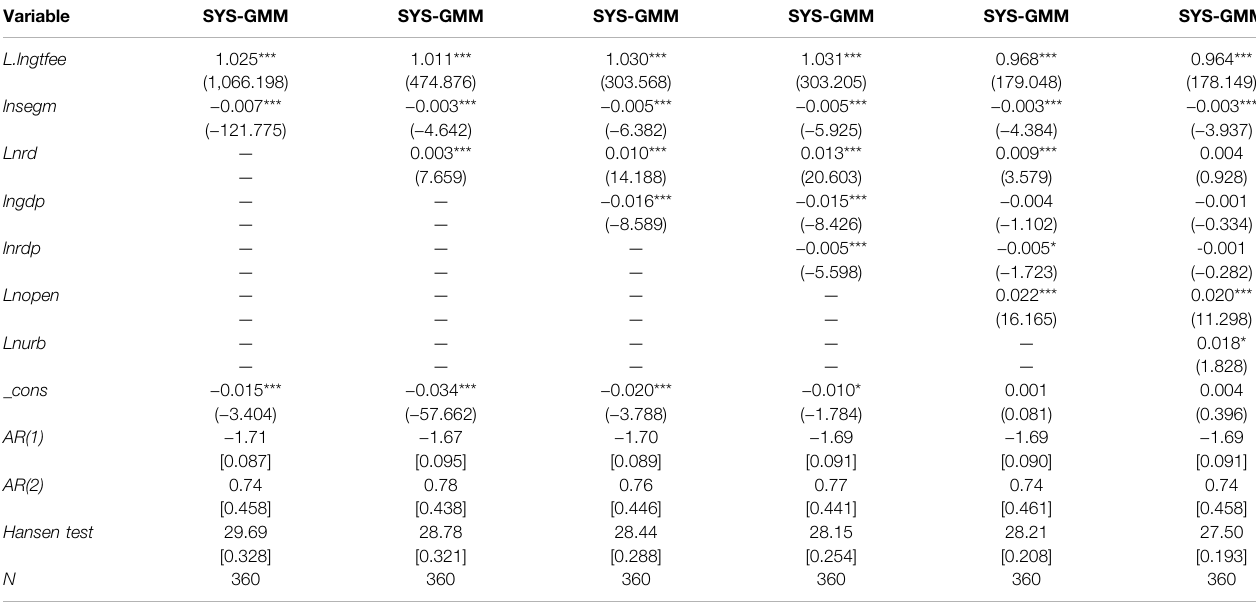
TABLE 3 | The empirical results of market segmentation on GTFEE.